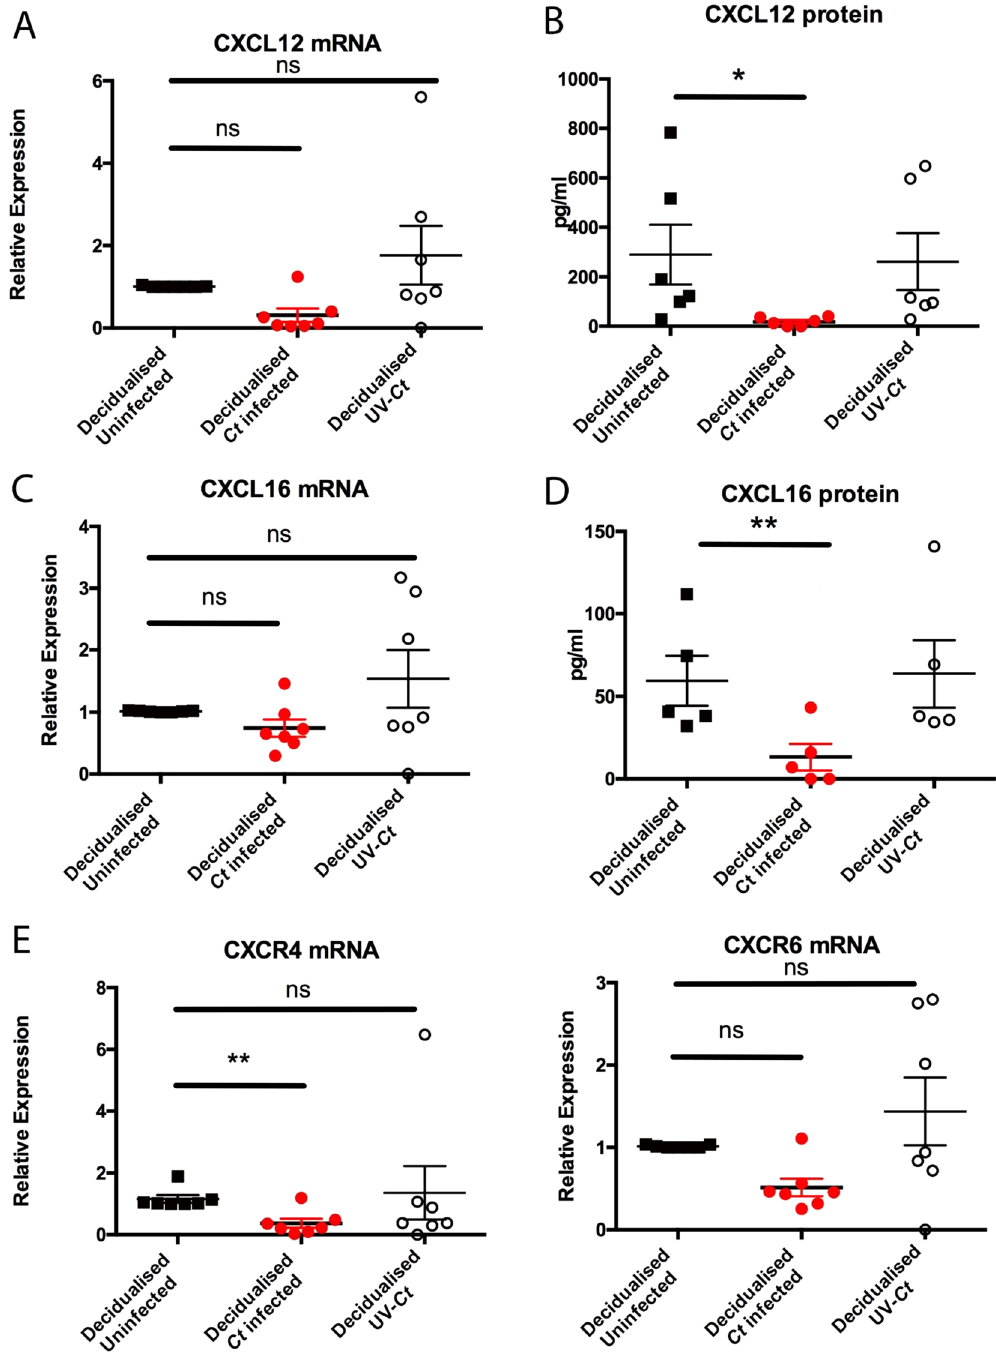
Figure 4. Innate immune response of decidualised ESC to Ct infection. The innate response was determined by measurement (at an mRNA and protein level) of trophoblast invasion-associated chemokines CXCL12 and CXCL16. ( A , B ) CXCL12 mRNA was not altered in response to infection, however there was a reduction in protein levels in cell supernatants (n = 4, One way ANOVA Friedman’s test with Dunn’s multiple comparisons test p = 0.0267). ( C , D ) Similarly, there was less secreted CXCL16 protein observed only in infected cells however no change in mRNA levels (n = 4, One way ANOVA Friedman’s test with Dunn’s multiple comparisons test, p = 0.0078). ( E ) CXR4 mRNA, receptor of CXCL12, was increased only in infected cells (n = 7, One way ANOVA Friedman’s test with Dunn’s multiple comparisons test, p = 0.0267). ( F ) CXCR6, receptor of CXCL16 does not seem to be affected by Ct infection in mRNA level. Each circle/square represents an individual